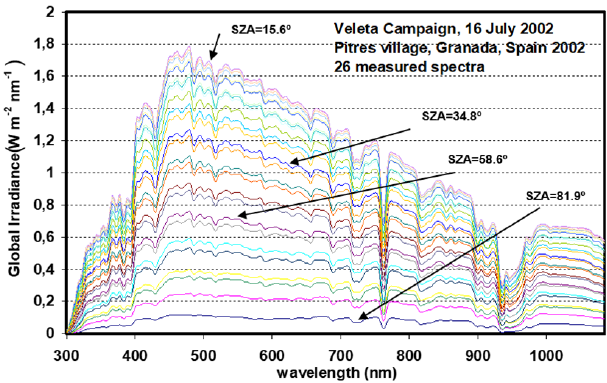
Figure 7. Solar global irradiance spectra measured by LI-1800 dur- ing the afternoon of 19 July 2002, during the Veleta campaign at Pitres (Granada,